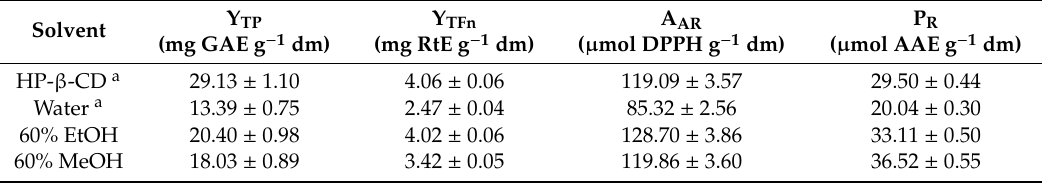
Table 3. Appraisal of hydroxypropyl β -cyclodextrin (HP- β -CD) as a co-solvent in the production of polyphenol-containing aqueous extracts from waste orange peels (WOP). Extractions were performed at 40 ◦ C, and values given represent average ± standard deviation.